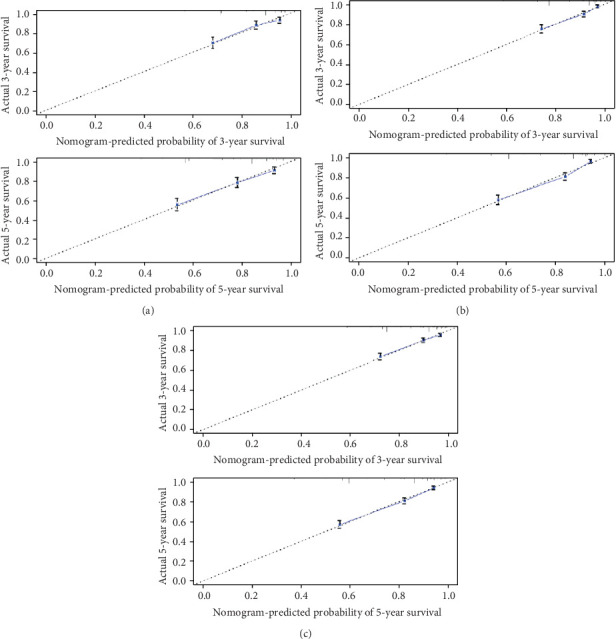
Calibration plots of the nomogram predictions of 3-year and 5-year overall survival of conjunctival cancers in the (a) 1992-2001, (b) 2002-2011, and (c) 1992-2011 patients cohorts. The blue line represents equivalence between the observed and predicted probabilities.